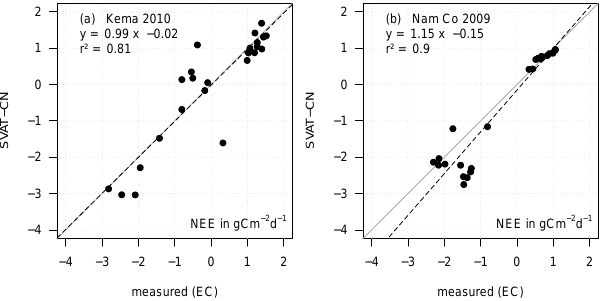
Figure B4. Comparison of hourly medians (see Fig. D3) of measured and modelled net ecosystem exchange for the 2010 campaign at Kema (left panel) and 2009 campaign at Nam Co (right panel). The regression line (dashed, black) is shown as well as the 1 : 1 line (solid, grey).